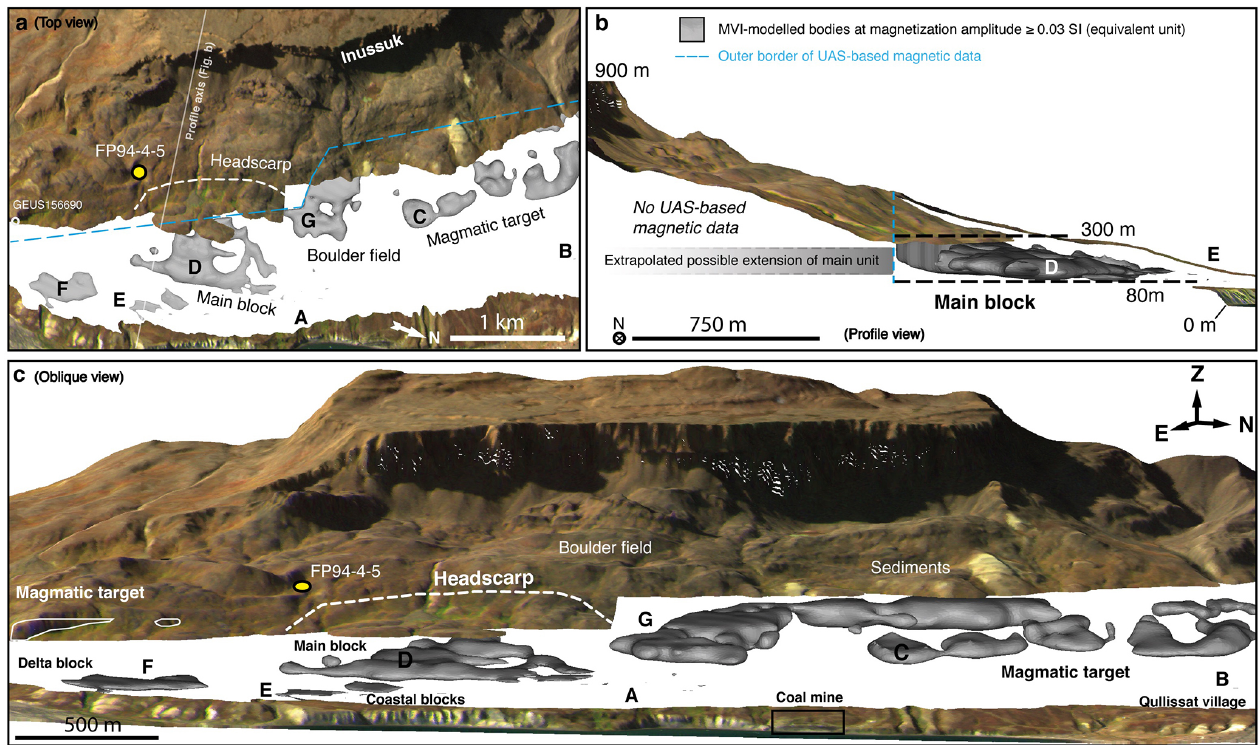
Figure 13. Combined plots of surface topography (PlanetScope mosaic fused with ArcticDEM) and larger magnetization amplitudes ( ≥ 0.03SI) in the subsurface from the MVI model: (a) top view of survey area; (b) side view cross section facing north – dashed lines indicate the maximum extension of the intrusive body; (c) oblique view from the east. In all three views the surface model is removed for areas where the magmatic body is present at the surface (compare Figs. 12a, 14a). A possible extension of the target unit is sketched next to the main block, anomaly